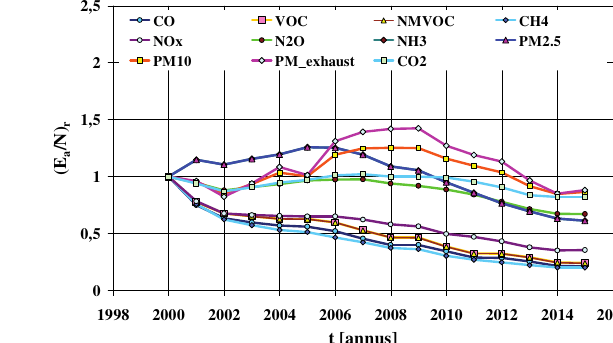
Fig. 13. National annual emission of particulate matter PM10 from tribological elements of passenger cars